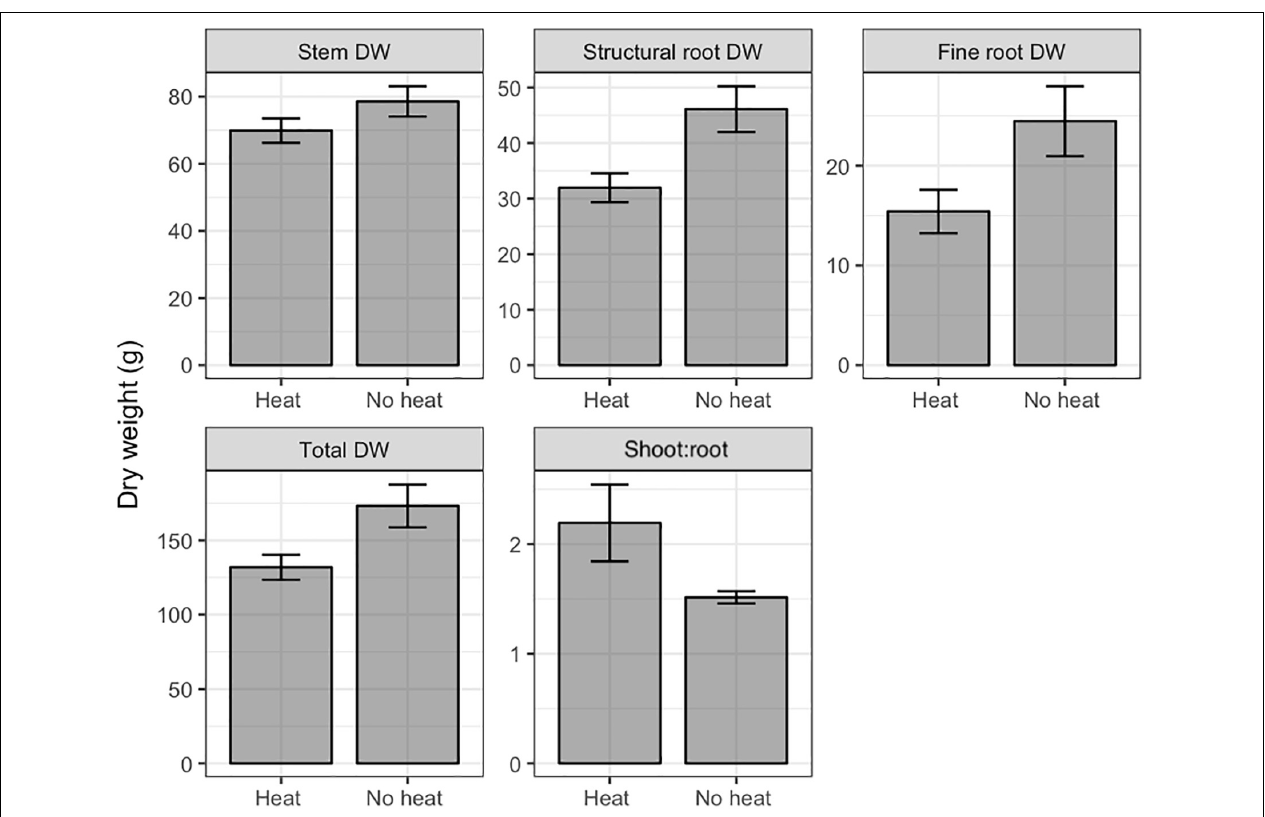
FIGURE 3 | Dry weights (DW) and leaf area of various organs of Valencia/X-639 citrus plants upon termination of Trial 2, 111 days after heat treatment. Shaded bars represent means, and error bars represent standard error ( n = 6). All contrasts significant at P < 0.05 using Bonferroni’s protected